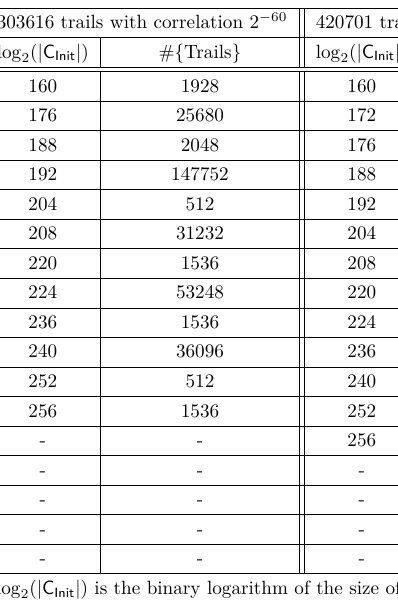
Table 2: Distribution for the number of linear